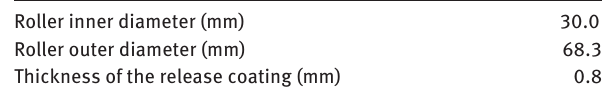
Figure 4 Required roller indentation at any path angle.